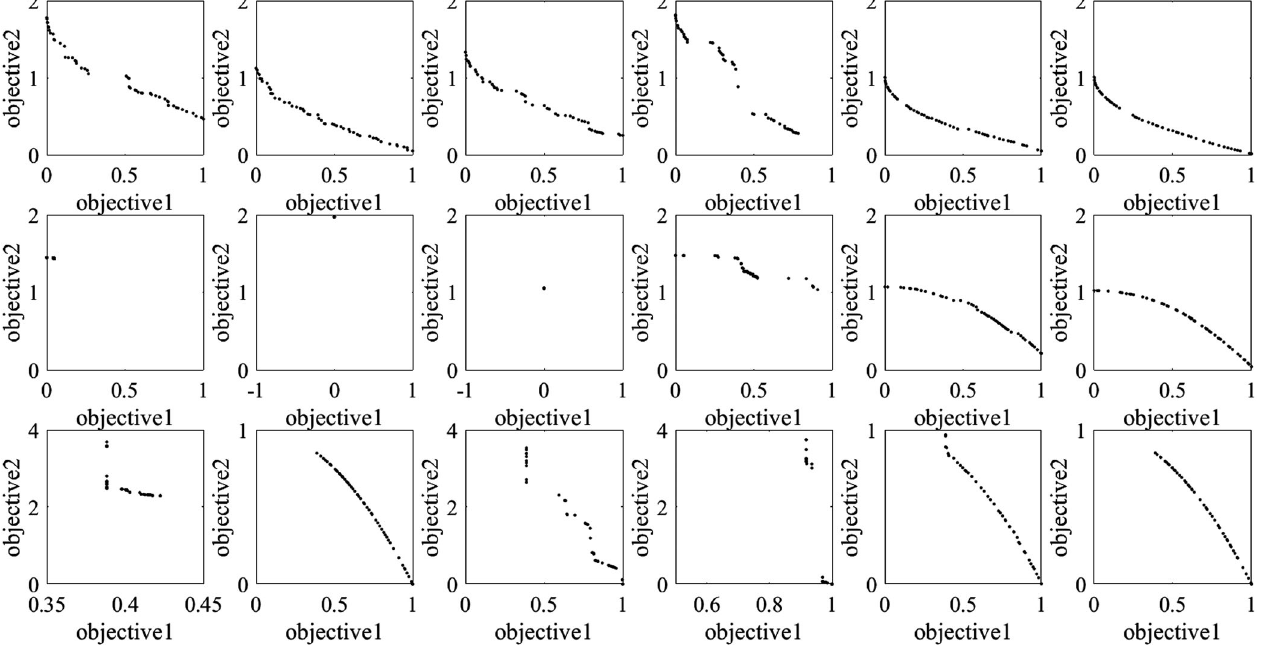
FIG. 6. The obtained solutions of the cases with a population size of 50. The rows from top to bottom represent the results of ZDT1 (100th generation), ZDT2 (300th generation), and ZDT6 (300th generation), respectively. The columns from left to right represent the results obtained with the standard MOGA, MOPSO, combination of MOPSO and MOGA, CEMOGA, NBMOGA ( K ¼ 5 ), and NBMOGA ( K ¼ 15 ),